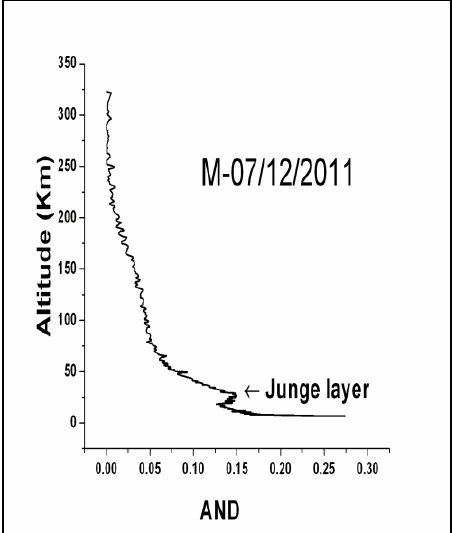
Figure 2: Aerosol vertical profiles in terms of